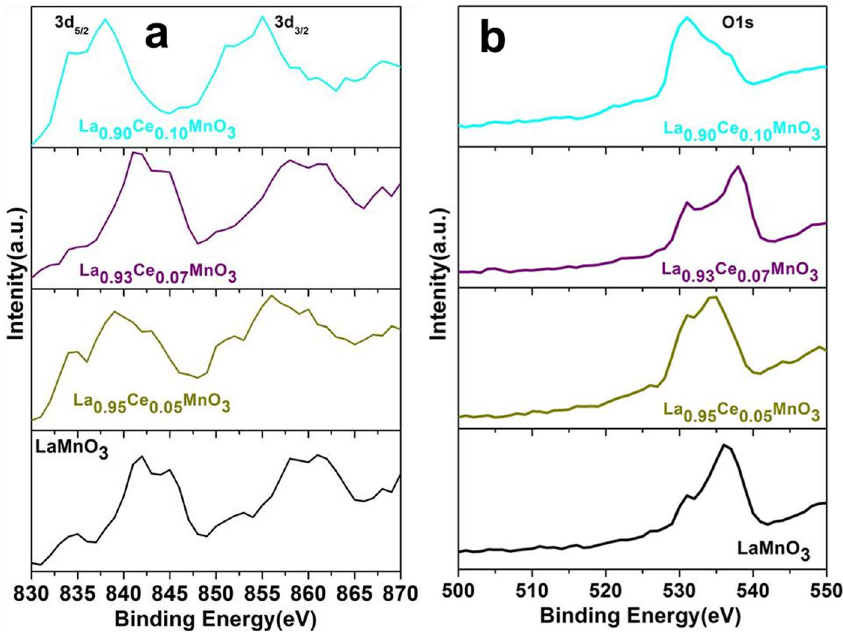
Figure 7. ( a ) XPS analysis of the La 3d 3/2&5/2 and ( b ) O1s spectra recorded for the LaMnO 3 , La 0.95 Ce 0.05 MnO 3 , La